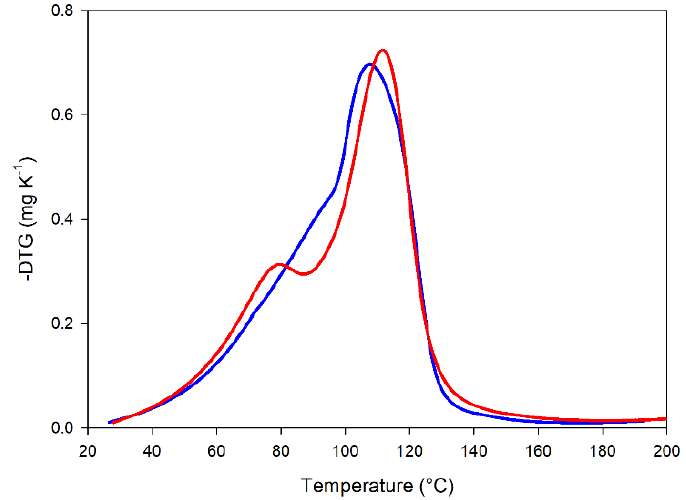
Figure 3. Derivative thermogravimetric (DTG) traces of dough from of raw (blue line) and heat- treated (red line) flours from red lentils at 60% moisture content.